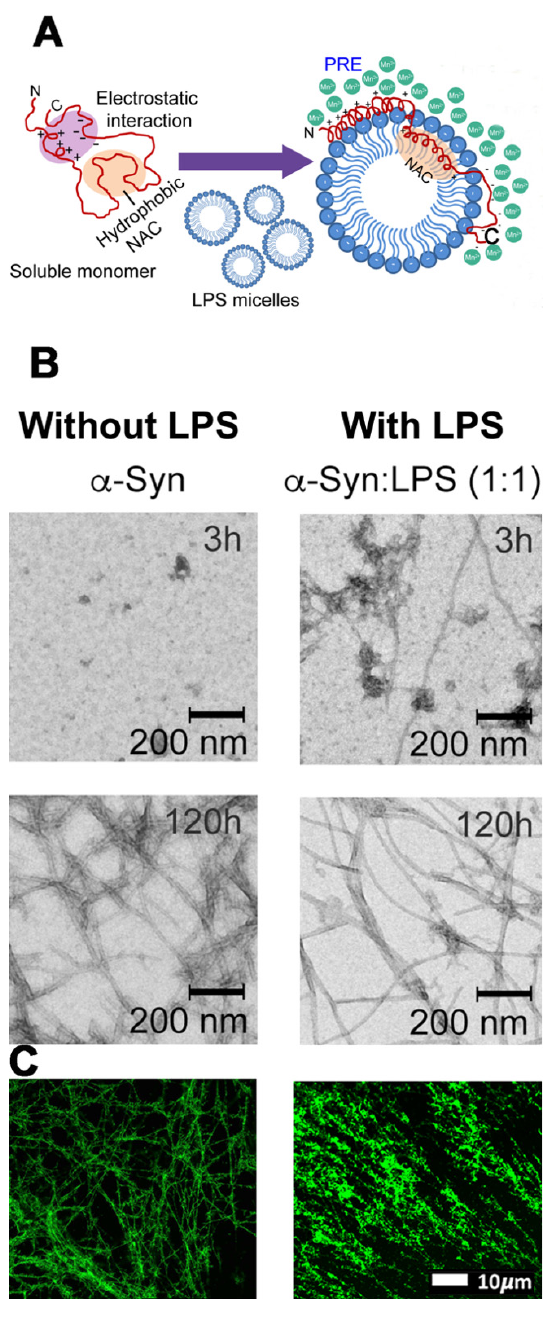
Figure 4. Courtesy of [23] (permission and license of usage were granted by publisher and supported by authors).( A ) Schematic representation of the orientation of α -Syn in aqueous solution (left) and in the presence of lipopolysaccharides (LPS) micelle (right). Paramagnetic relaxation enhancement (PRE), using MnCl 2 as quenching agent, herein indicated only as “Mn,” was used by the authors to verify internalization of the N-terminal- and NAC regions of α -Syn into the LPS micelle. ( B ) Transmission electron microscopy (TEM) images showing morphologically distinct α -Syn fibrils at 1:1 LPS concentration at two different time points ( t = 3 and 120 h). Scale = 200 nm. ( C ) Confocal microscopy images of fibrin networks formed from purified fibrinogen (with added Alexa 488 fluorophore) incubated with and without LPS from P. gingivalis , followed by addition of thrombin to create extensive fibrin(ogen) clots (unused raw data from [45].